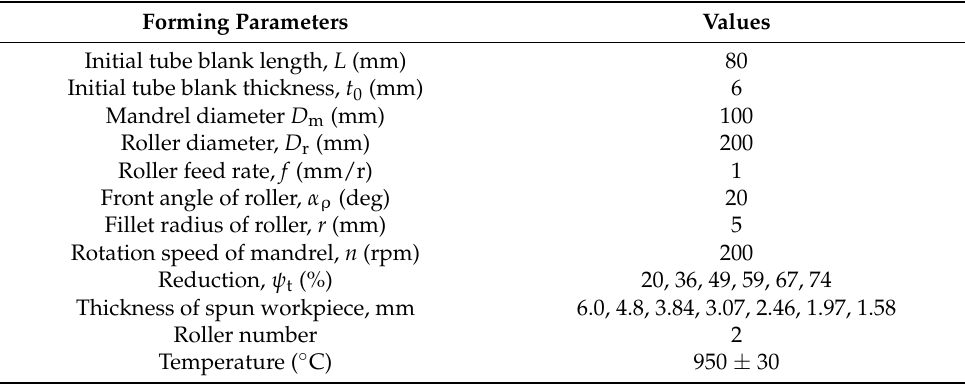
Table 1. Main process parameters of hot power spinning. Forming Parameters Values Initial tube blank length, L (mm)